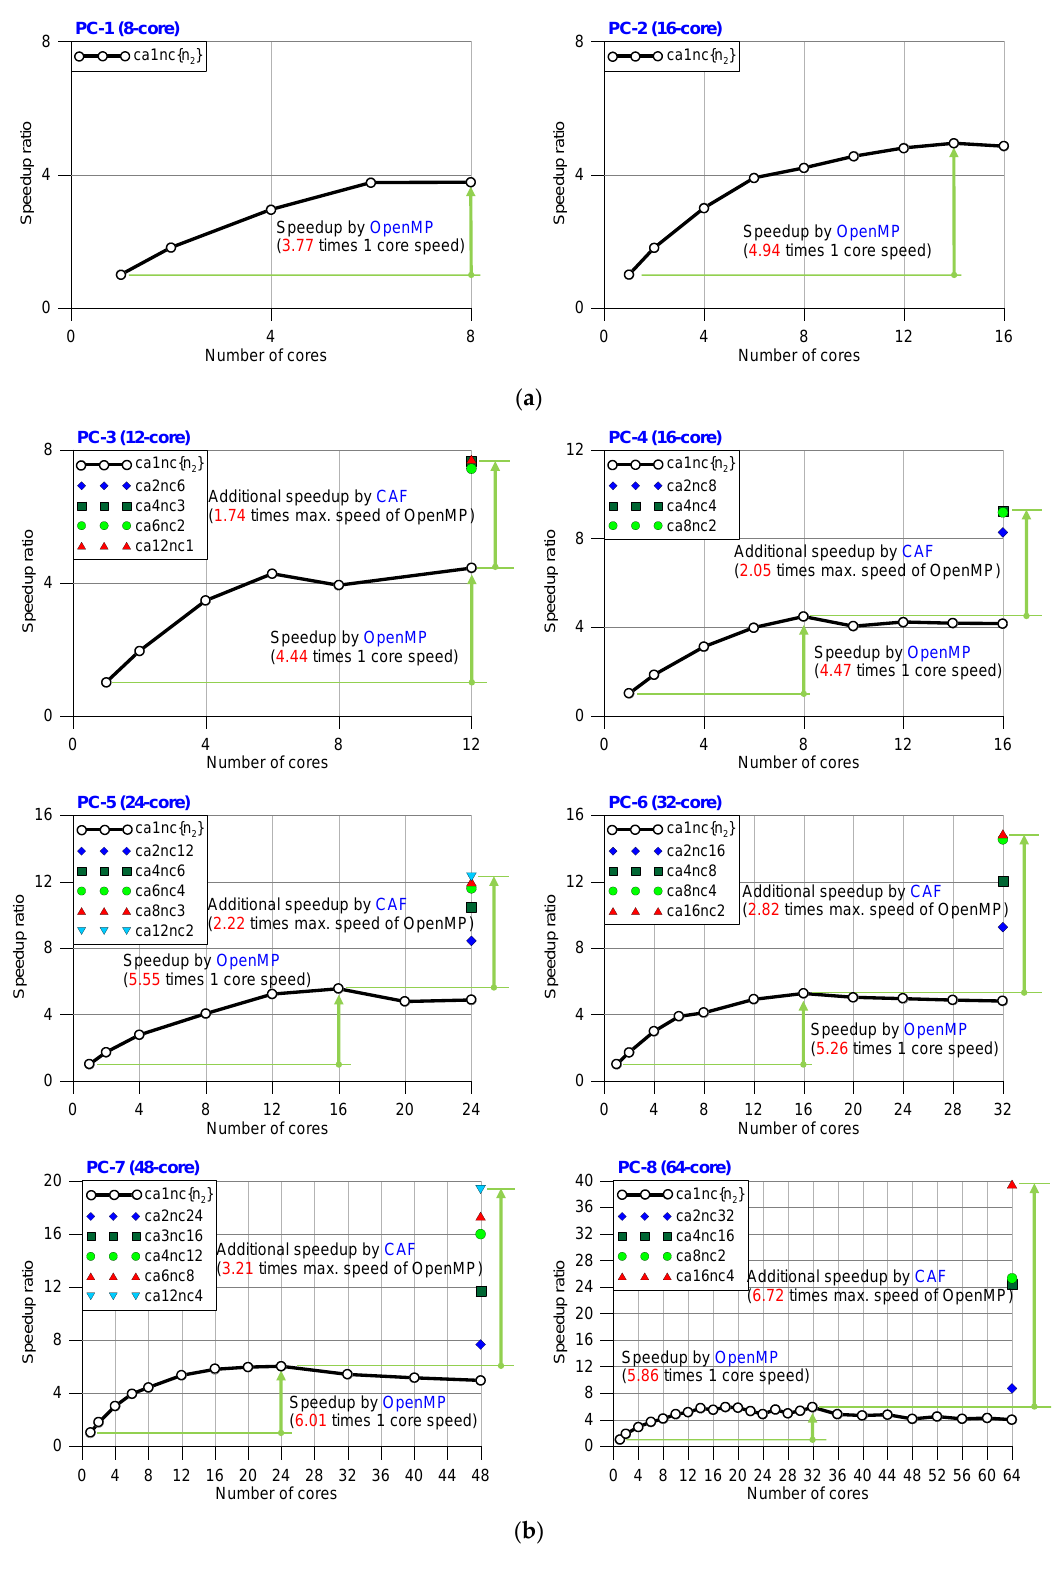
Figure 6. Speedup ratios for OpenMP and OpenMP+CAF for the shallow foundation example using various multi-core computer systems (abbreviation: ca{ 𝑛 1 }nc{ 𝑛 2 }; 𝑛 1 = number of coarrays; 𝑛 2 = number of cores/image): ( a ) Single-CPU computer systems; ( b ) Dual-CPU computer systems.